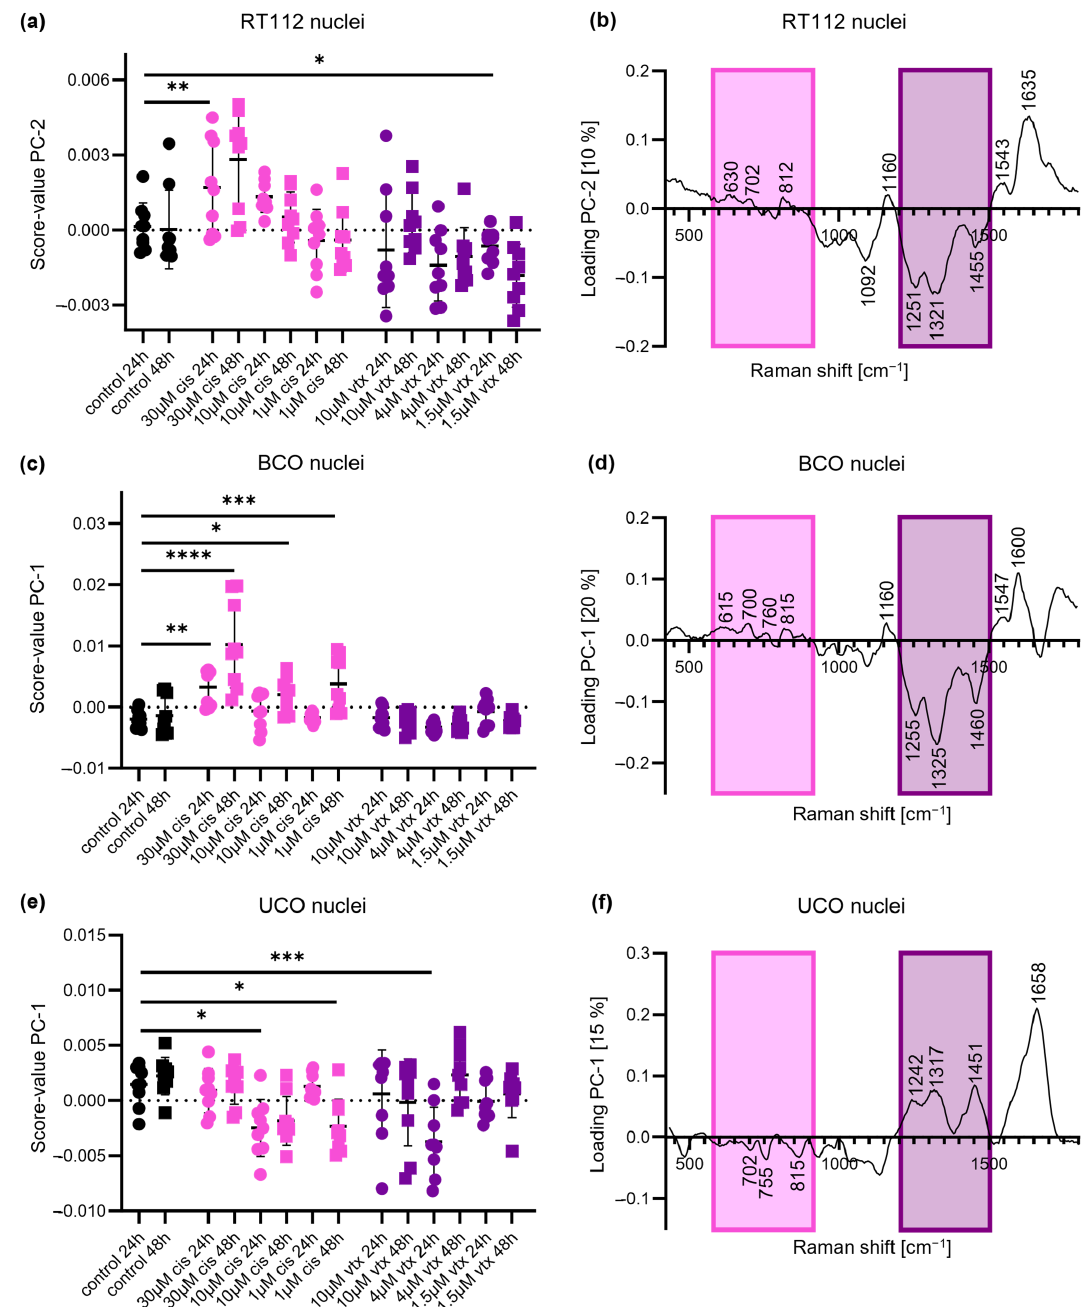
Figure 2. PCA of nuclei-derived Raman spectra reveals similar spectral changes for all organoid models after cis (pink) and vtx (purple) treatments . ( a ) Score value analysis of the cell line RT112 shows statistically significant differences after cis and vtx treatment. ( b ) Corresponding loading plot. ( c ) Score value analysis of patient-derived BCOs shows statistically significant differences after cis treatment and tendencies of separation after vtx treatment. ( d ) Corresponding loading plot. ( e ) Score value analysis of patient-derived UCOs reveals statistically significant differences between controls and cis and vtx treatment. ( f ) Corresponding loading plot. Black: controls; pink: cis treatment; purple: vtx treatment; circles: 24 h; square: 48 h; Statistical analysis: One-way ANOVA, n = 9, * p < 0.05, ** p < 0.01, *** p < 0.001, **** p <